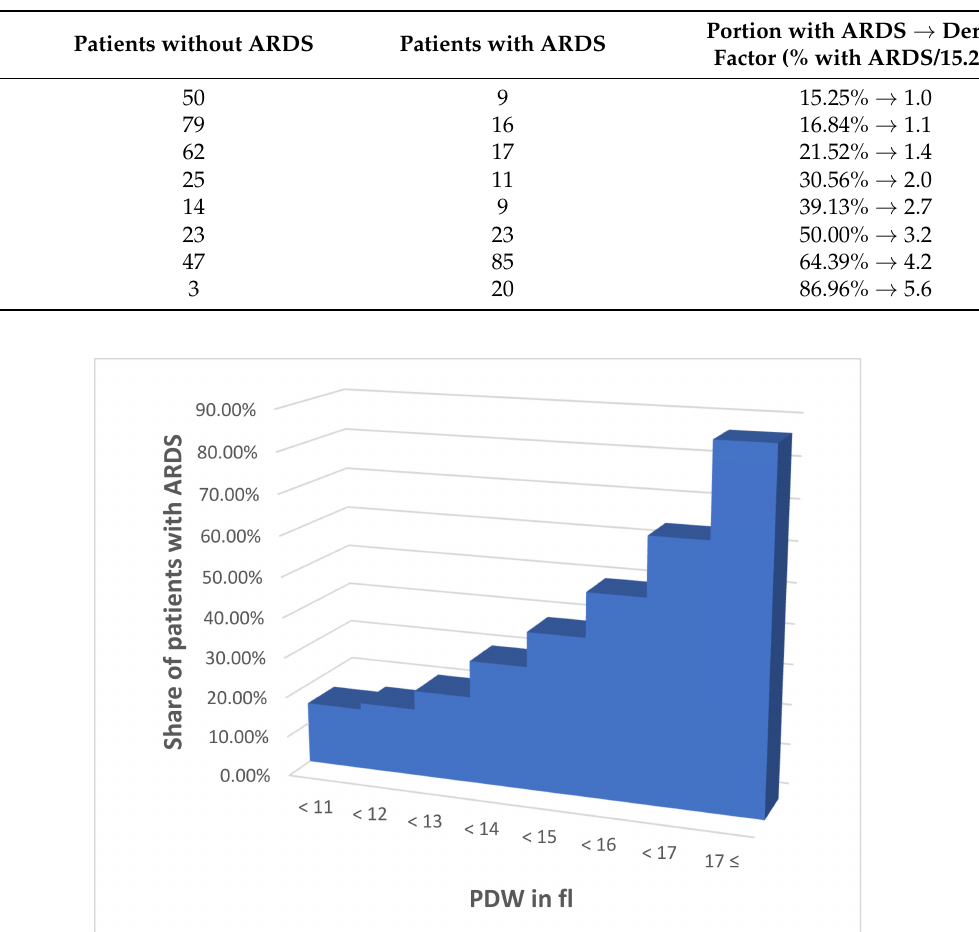
Table 2. Crosstabulation between PDW interval and the presence of ARDS.